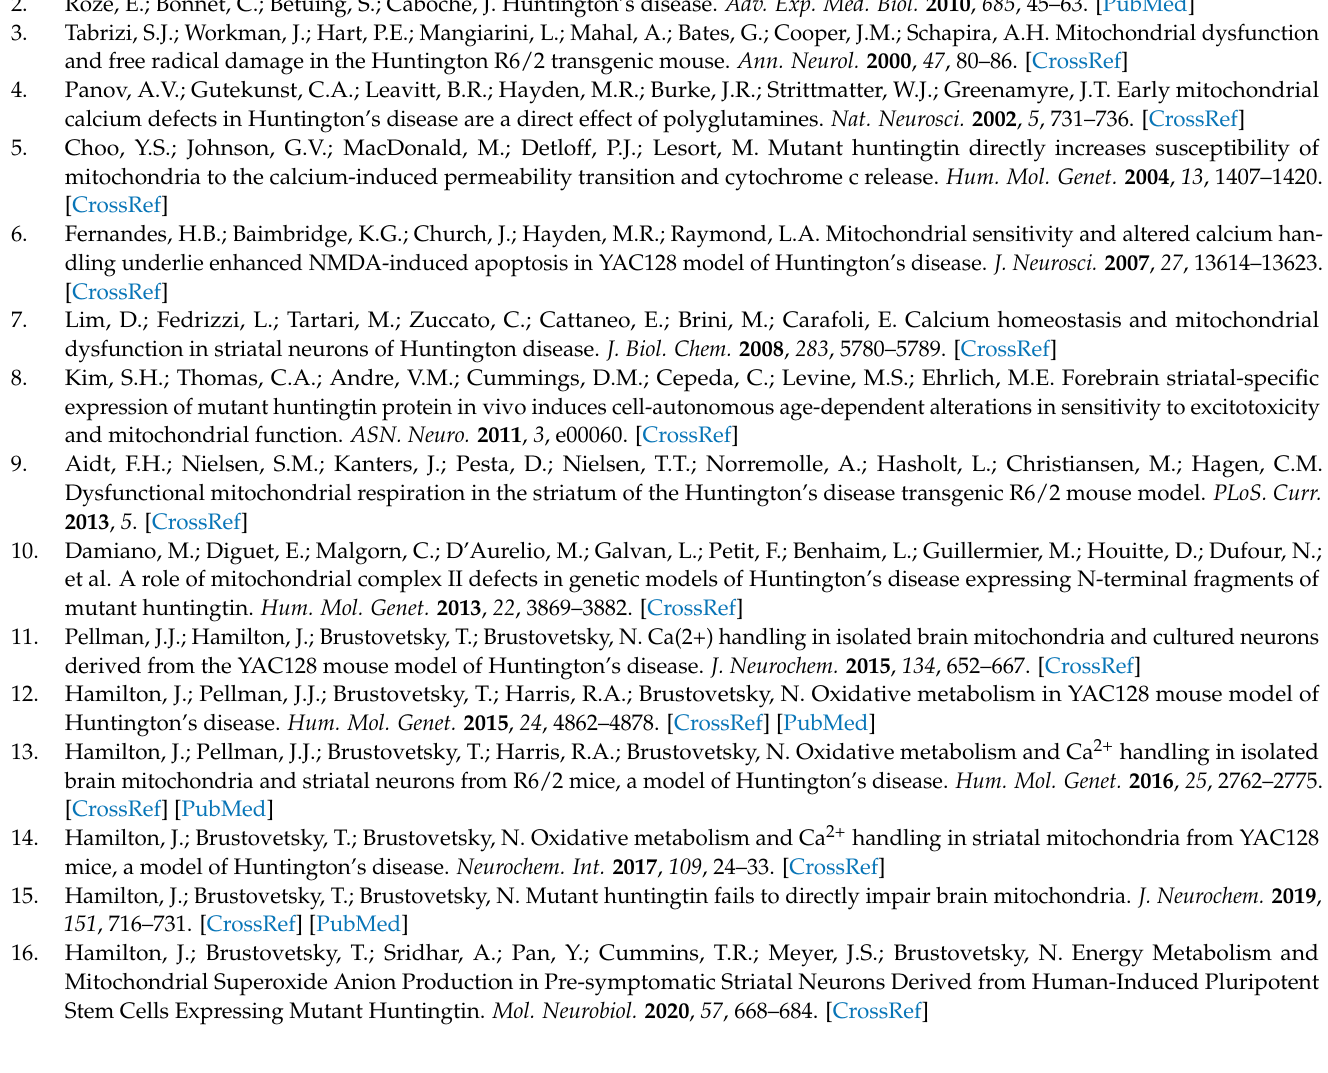
for Figure 3A,B. Figure S4. The unedited images of immunoblots for Figure 4A,B. Table S1. Main characteristics of human postmortem brain